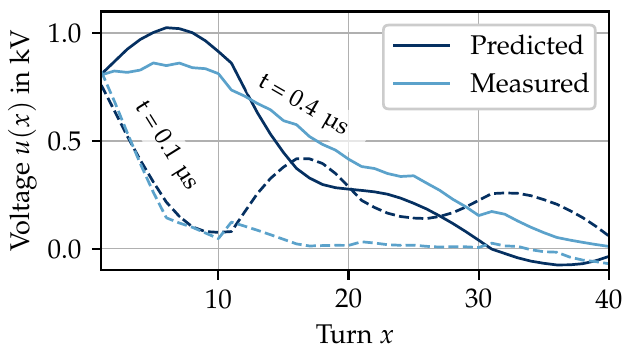
Figure 15. Measured and predicted potential distribution for stator specimen S3 at different points in time